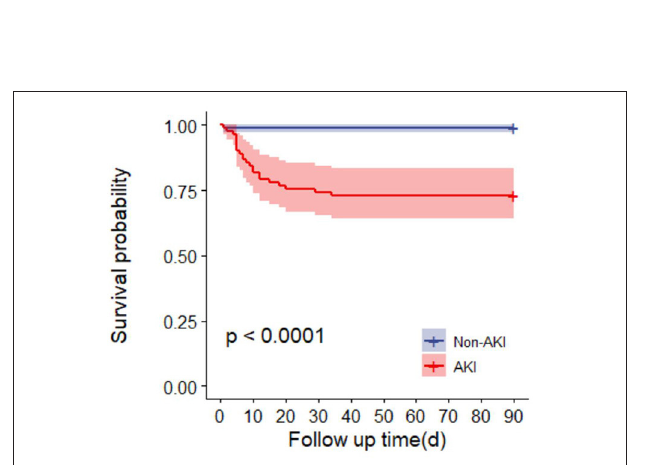
FIGURE 2 | ROC curves in predicting 90-day mortality with AKI patients induced by EHS. (A) The AUC of SOFA score was 0.920 (95%CI 0.842–0.998, P < 0.001), the optimal cutoff was 7.5 scores, the sensitivity was 91.7%, and the specificity was 80.5%. (B) The AUC of GCS score was 0.851 (95%CI 0.739–0.962, P < 0.001), the optimal cutoff was 8.5 scores, the sensitivity was 91.7%, and the specificity was 68.3%.